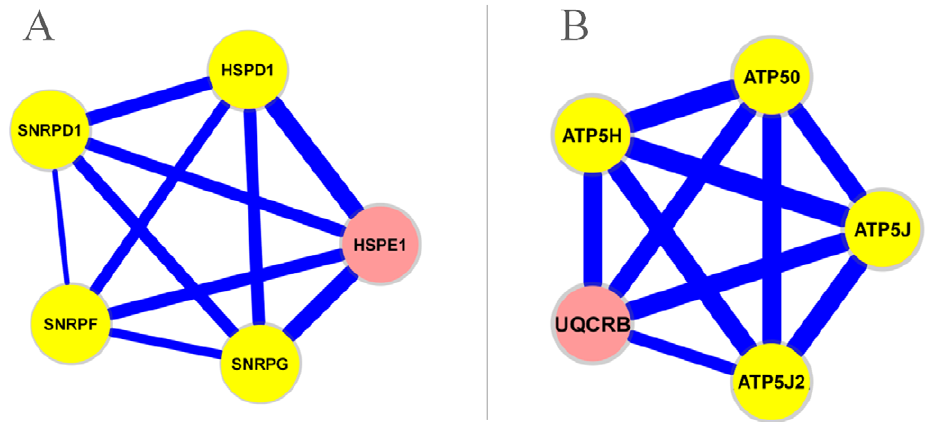
Figure 6. Two modules are enriched in protein complexes. The modulein ( A ) is enriched in the U2 snRNP 17Sprotein complex ( q -value=9.9E-5) and the module in ( B ) is enriched in the F1F0 ATPase protein complex ( q -value=1.8E-6). The members of the protein complexes are colored in yellow. The width of an edge is proportional to the average correlation of its genes in the datasets where the module occurs.